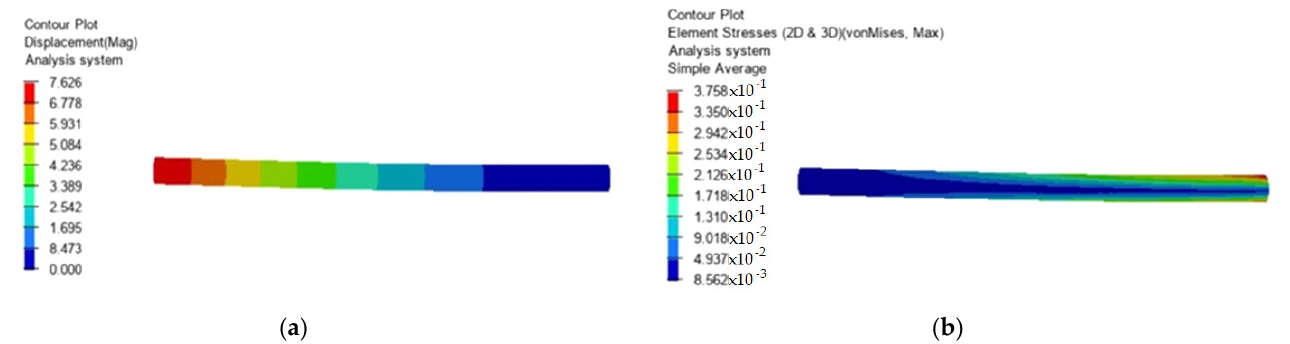
Figure 1. Material without voids. ( a ) Displacement (mm); ( b ) Stress